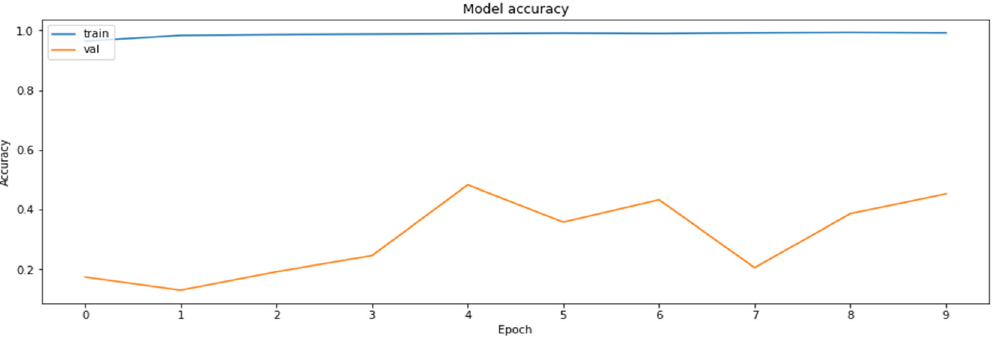
of the model. the model.